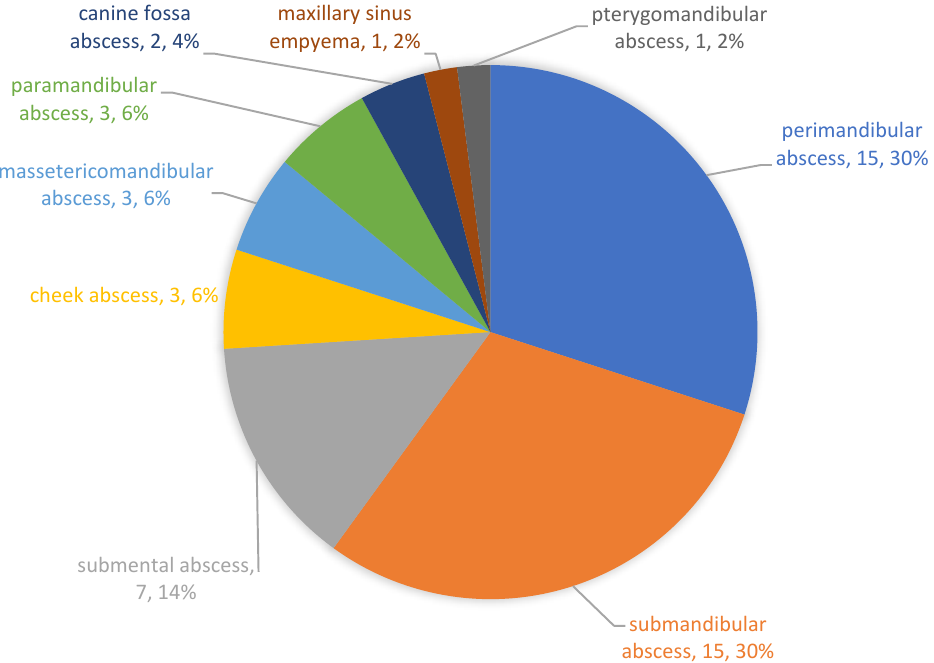
Figure 1. Frequency of the observed abscesses. The most common abscesses were the perimandibular and the submandibular